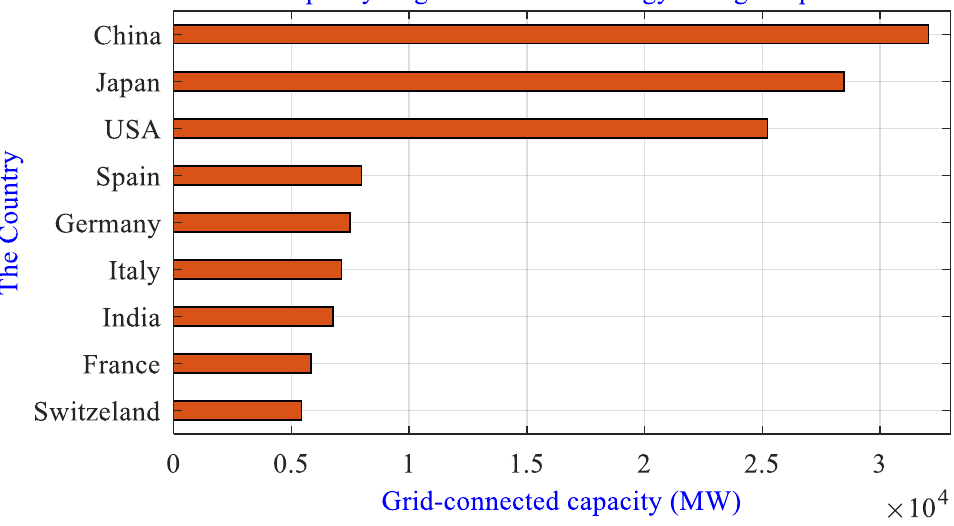
Figure 7. Energy storage additions per country from 2015 to 2020 [47]. 4. Hybrid Energy Storage: Design and Classifications In general, an HESS is made up of two or more types of storage devices that work together to make it better than single-component energy storage technologies, such as bat- 0